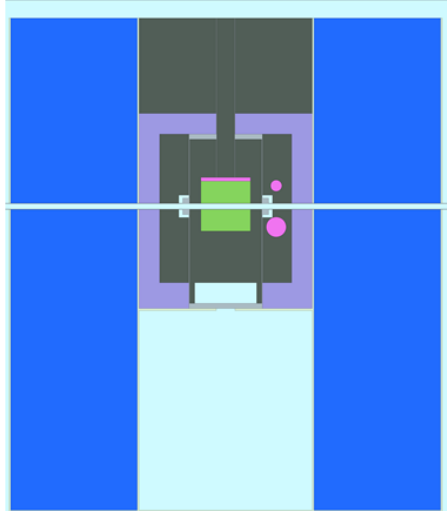
Fig. 6 - Vertical cut view of the Serpent2 SUR-100